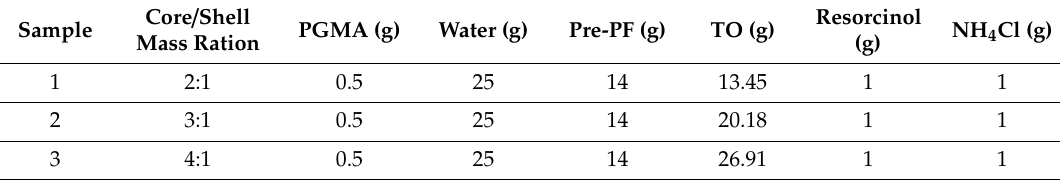
Table 1. Recipes of TO-loaded microcapsules synthesized with di ff erent core / shell mass rations.